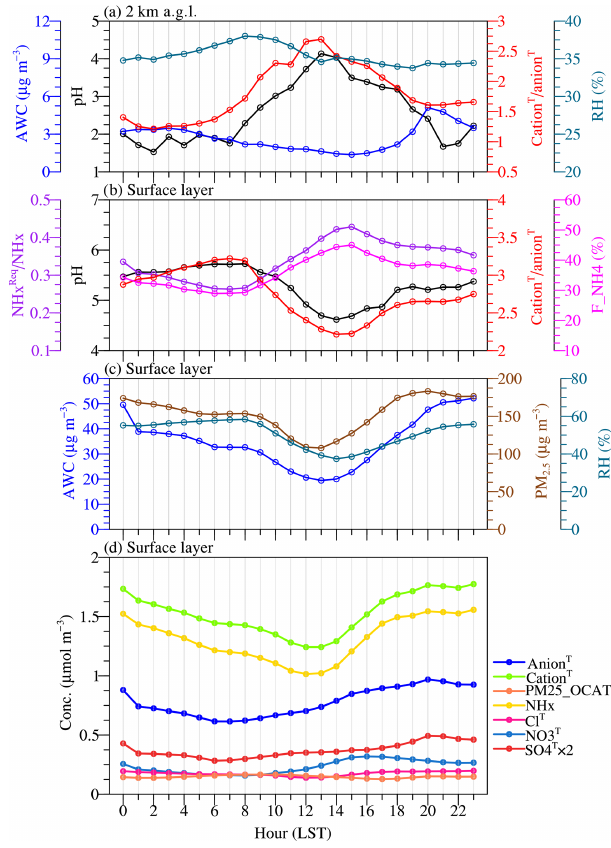
Figure 4. Monthly mean diurnal cycle for (a) fine particle pH, aerosol liquid water content (AWC), the mole ratio of total poten- tial cation (cation T ) to total potential anion (anion T ), and relative humidity (RH) at 2kma.g.l., (b) fine particle pH, the mole ratio of cation T to anion T , the mole ratio of required NH x (NH Req x ) to NH x , and fraction of NH x in the particle phase (F_NH4) at the surface layer, (c) AWC, RH, and PM 2 . 5 concentrations at the surface layer, and (d) concentrations of total sulfate (SO4 T ), total nitrate (NO3 T ), total chloride (Cl T ), total ammonia (NH x ), PM25_OCAT, cation T , and anion T at the surface layer simulated in the CTRL scenario at the Beijing TSU site during January